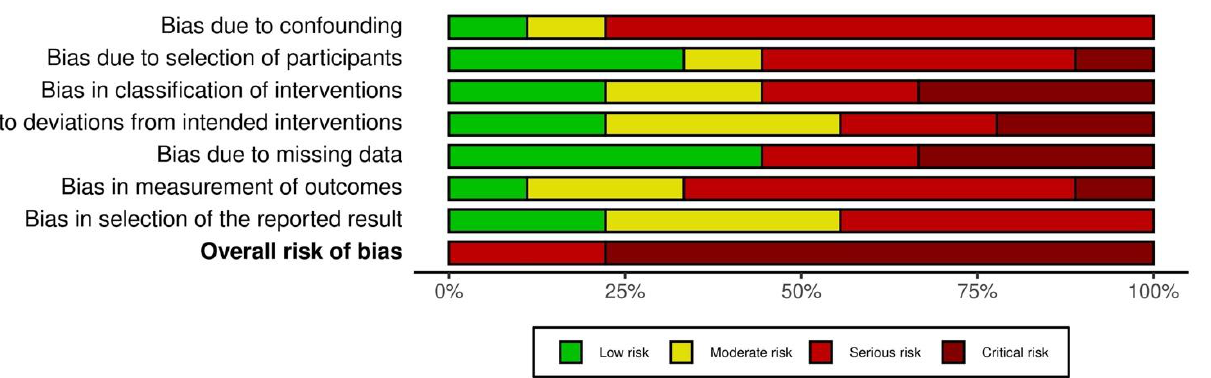
Figure 2 ROBINS-I Traffic Light Plot bias assessment.